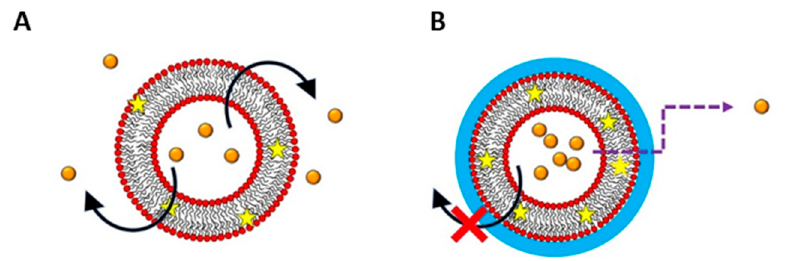
Figure 4. ( A ) Conventional liposome-bearing hydrophilic (orange balls) and hydrophobic (yellow stars) loads. The hydrophilic cargo tends to cross the bilayer leaking to the external aqueous phase. ( B ) Polymer-coated liposome with reduced bilayer permeability and higher cargo retention, enabling sustained and controlled drug delivery.